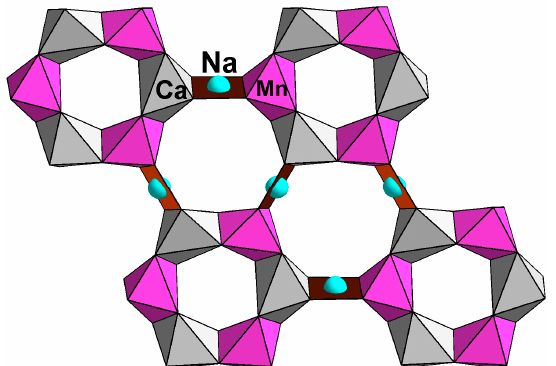
Figure 6. Combination of the rings of Ca- and Mn-centered octahedra via Na atoms having flat square coordination in the structure of Sample 10 (Table 4) [30].